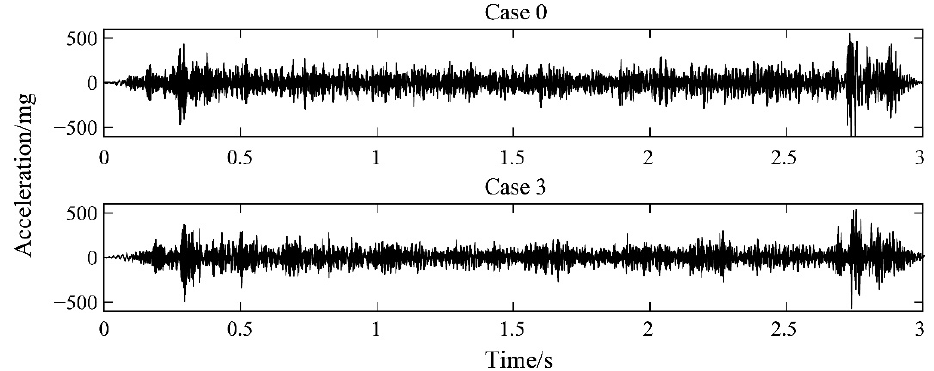
Figure 7. Original signal of the vehicle in modelling test.